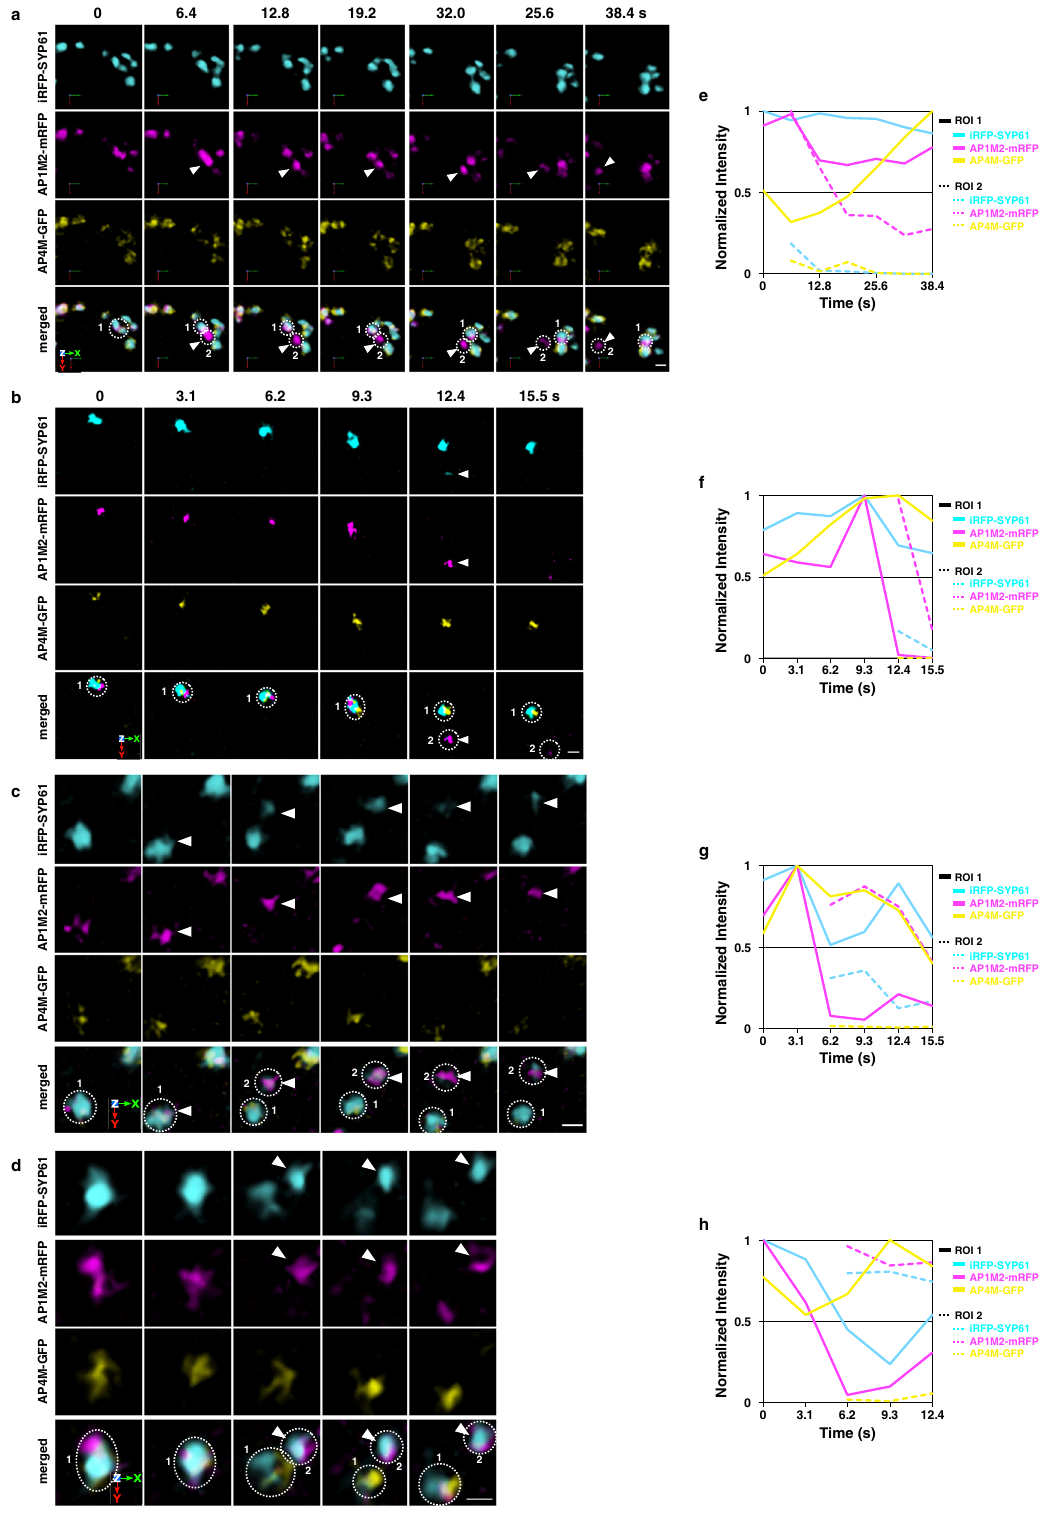
Fig. 4 AP-1, but not AP-4, buds from the TGN. a – d 3D time-lapse (4D) images of iRFP-SYP61, AP1M2-mRFP, and AP4M-GFP in the epidermal cells of the root elongation zone under SCLIM. Arrowheads indicate the dissociation of AP1M2-mRFP and iRFP-SYP61 from a large population of TGN labeled with iRFP-SYP61. Images are lined up every 6.4 s ( a ) or 3.1 s ( b – d ) from left to right. Scale bars = 1 μ m. e – h Time course changes in relative fl uorescence intensities of iRFP-SYP61, AP1M2-mRFP, and AP4M-GFP in ROIs of a – d . The experiments were repeated independently six times with similar results, and micrographs from representative experiments are